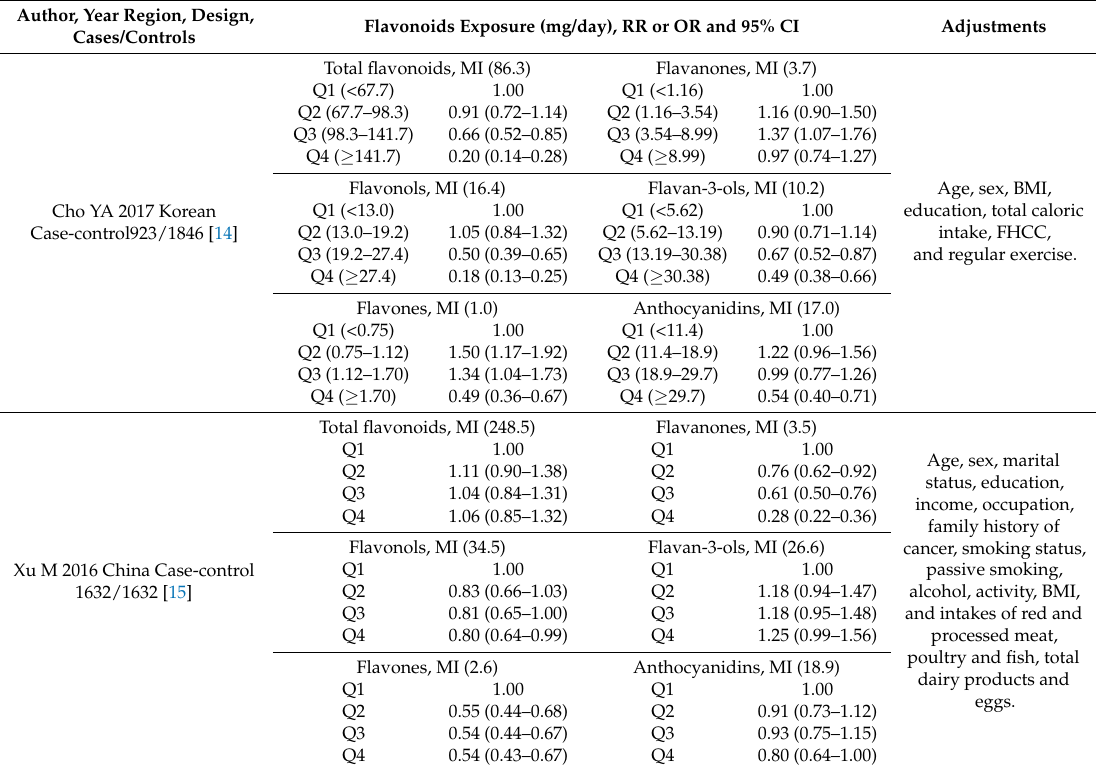
Table 1. Characteristics of the included